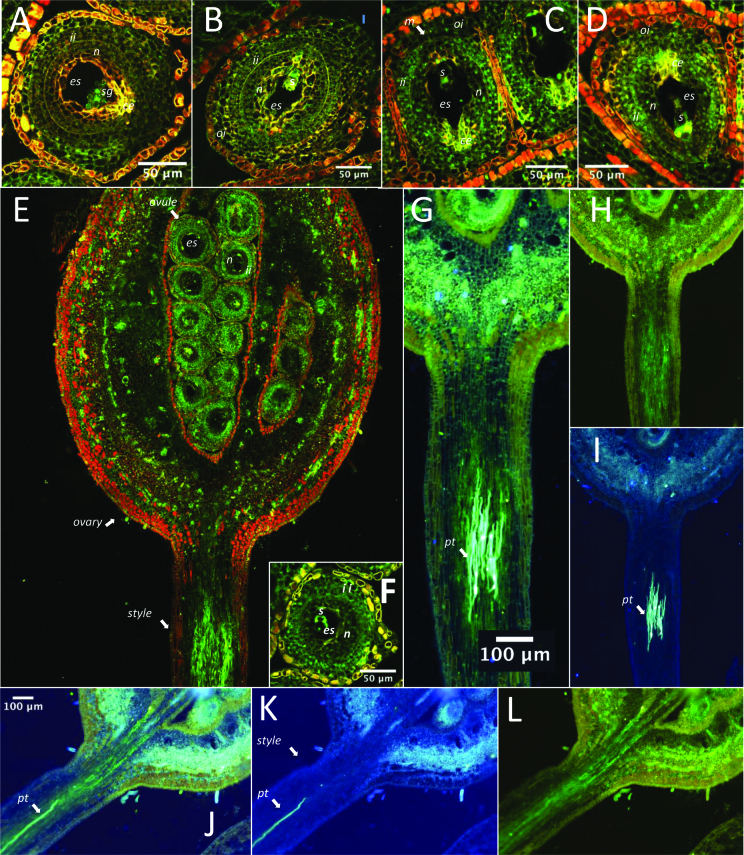
Immunolocalization of the Tc01_g007270 protein. (A–F) Confocal microscope images of sections of ovules, ovary, and style of the Scavina 6 accession either self-pollinated (self-incompatible, SI) or pollinated by a compatible pollen (SC) and probed with a Tc01_g0007270 antibody (labelled green). (A) Controlled hybridization labelled with pre-immuned rabbit serum for an ovule subjected to SC pollination. (B–F) Sections of ovules and ovary probed by a Tc01_g0007270 antibody: (B) unpollinated, (C) SC at 8 h, (D) SI at 8 h, (E) SC at 24 h, and (F) SI at 24 h. The Tc01_g0007270 protein appeared mostly present in the inner integument cells for the SC and SI reactions. (G–L) Images (Nikon microscope) of pollen tube germination at 8 h (J–L) and 24 h (G–I, same style as shown in image E) probed with Tc01_g0007270 antibody and stained with anilin blue. (I, K) Visualization of pollen tube germination (light blue), (H, L) Tc01_g0007270 protein immunolocalization, (G, J) merged images. The Tc01_g0007270 protein did not seem to be present in the pollen tubes themselves, as observed at 8 or 24 h after pollination, but seemed to be localized in the style tissues surrounding them. Abbreviations: es, embryo sac; s, synergid cell; sg, starch grains surrounding the polar nucleus; n, nucellus; oi, outer integuments; ii, inner integuments; m, micropyle; ce, chalazal end; pt, pollen tube.